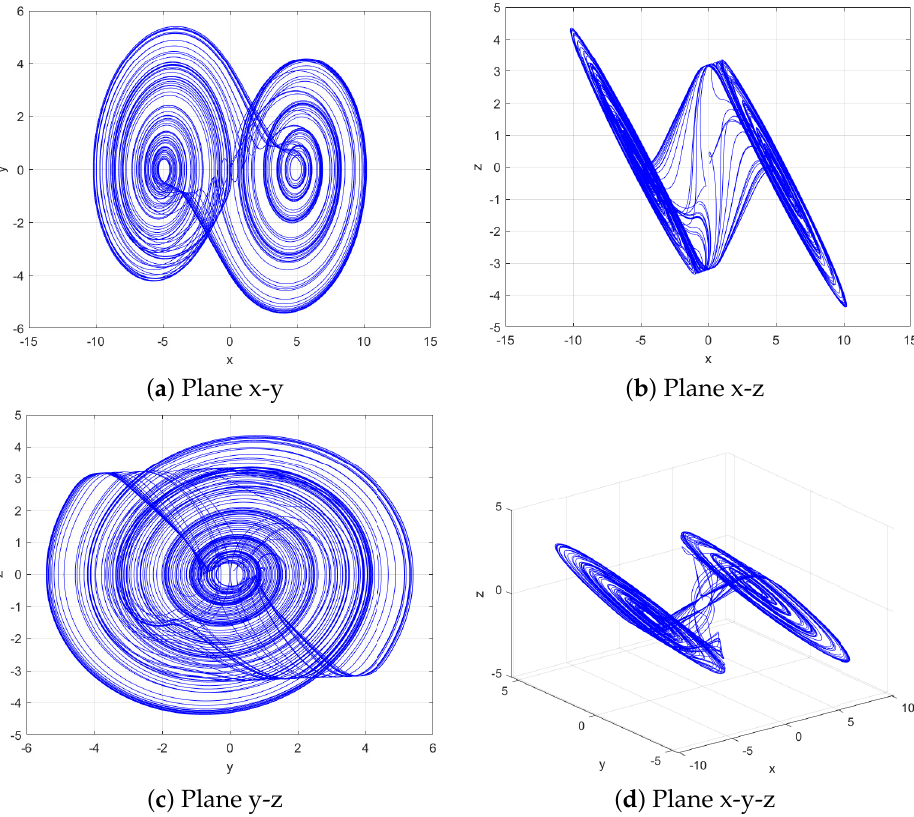
Figure 3. Phase-space portraits of the Lü chaotic system given in